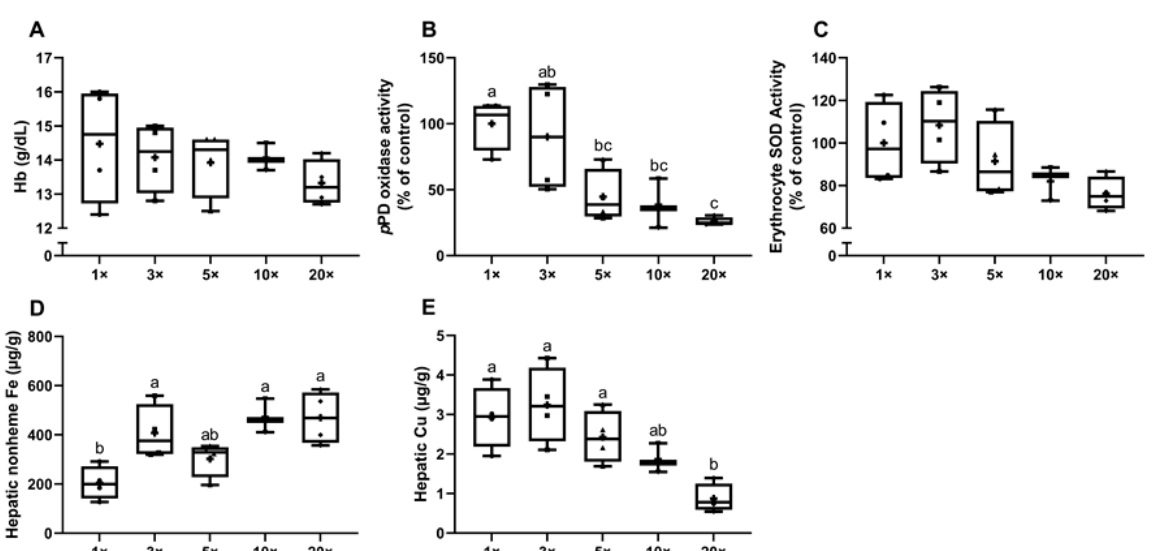
Figure 3. Consumption of a high-iron diet by previously iron-deficient rat dams perturbs iron and copper homeostasis. Blood hemoglobin (Hb) levels ( A ), serum p PD oxidase activity ( B ), erythrocyte SOD1 activity ( C ), hepatic nonheme iron content ( D ), and hepatic copper concentrations ( E ) were assessed in dams fed diets varying in iron concentration for ~3.5 weeks during pregnancy and lactation. One-way ANOVA analysis results are as follows: p PD oxidase activity ( B ), p = 0.0023; hepatic nonheme Fe content ( D ), p = 0.0038; hepatic Cu content ( E ), p = 0.0022. When statistically significant differences were noted by one-way ANOVA, Tukey’s post hoc test was utilized to make comparisons between individual groups. Values without common superscript letters are statistically different from one another ( p < 0.05 ). ( B,D,E ). All data points are shown, and the mean values are indicated by “+” signs.